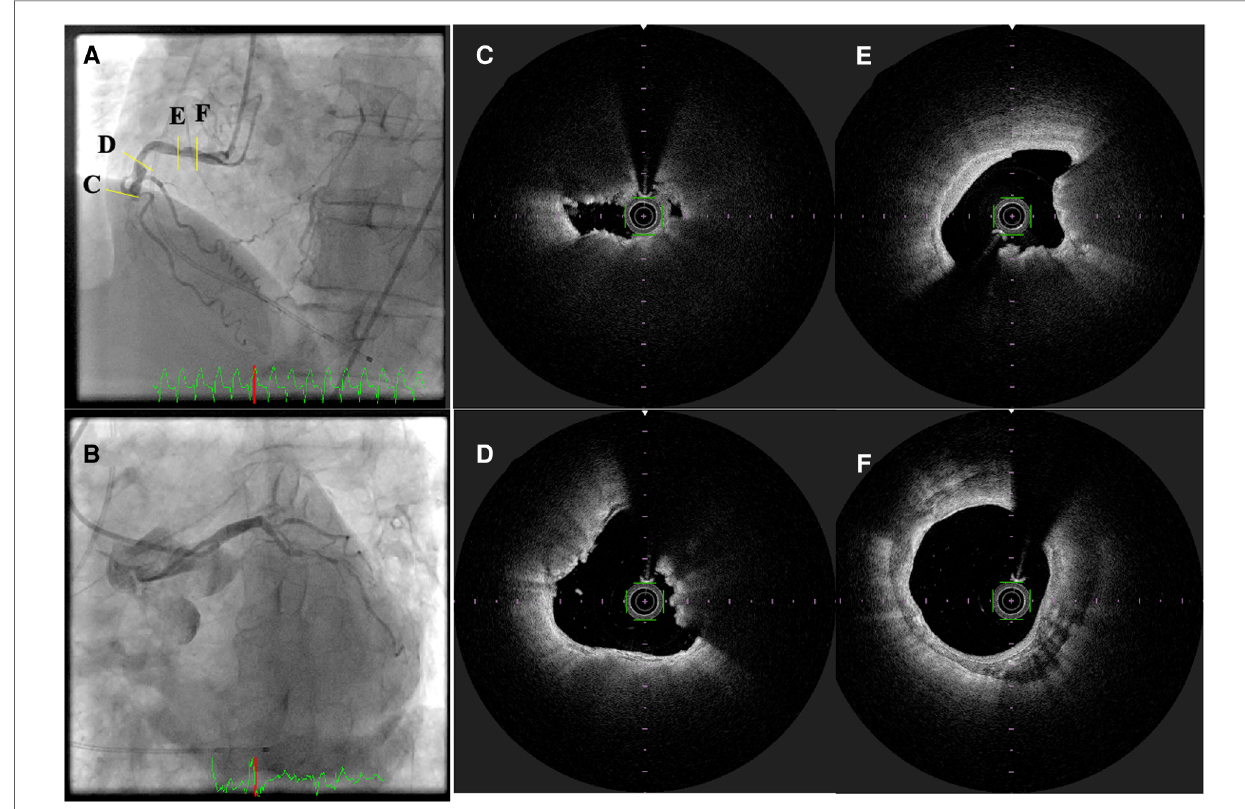
FIGURE 4 Optical frequency domain imaging of ST-segment elevation myocardial infarction. ( A,B ) Invasive coronary angiography revealed total occlusion of the mid-portion of the right coronary artery with collateral fl ow to the left descending coronary artery. ( C – F ) optical frequency domain imaging (OFDI) images after thrombectomy. ( C ) Thin capped fi broatheroma, ( D,E ) calci fi ed nodules (yellow arrows), and ( F ) calci fi